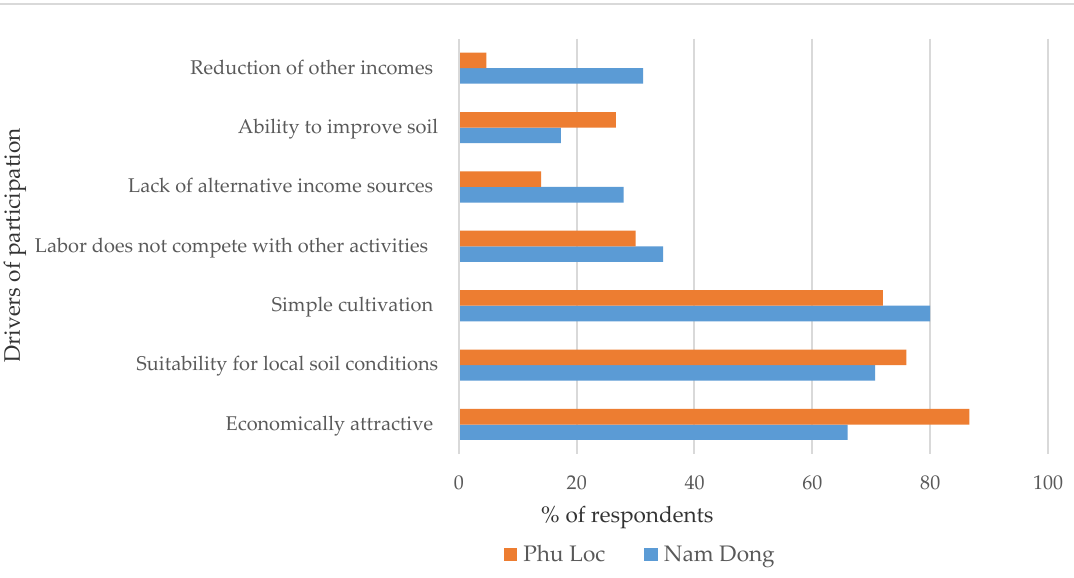
Table 5. Producers’ levels of involvement in the Acacia hybrid timber business in Nam Dong and Phu Loc districts.